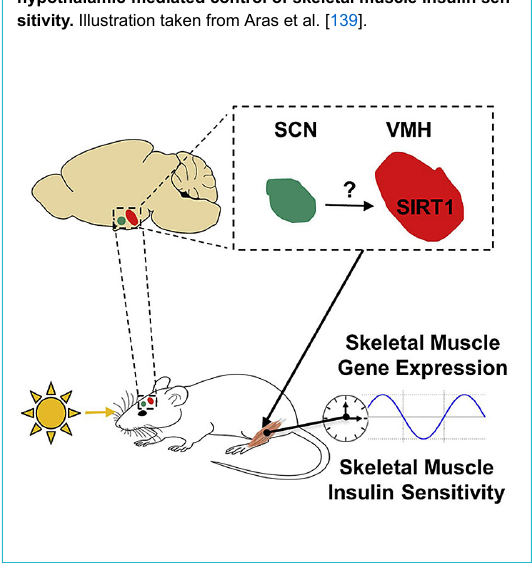
Figure 3: Schematic representation of the photic-induced and hypothalamic-mediated control of skeletal muscle insulin sen- sitivity. Illustration taken from Aras et al.